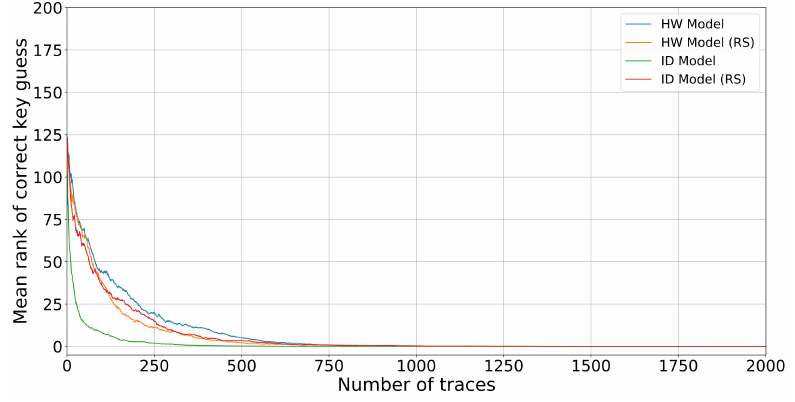
Figure 8: Guessing entropy for the ASCAD with random keys